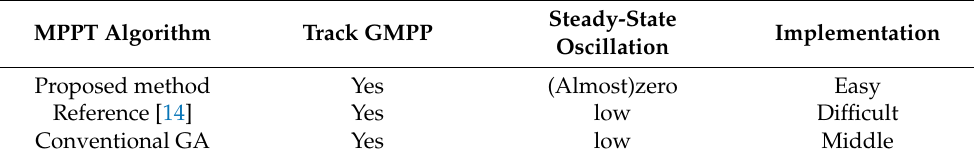
Table 4. Comparison of MPPT methods.